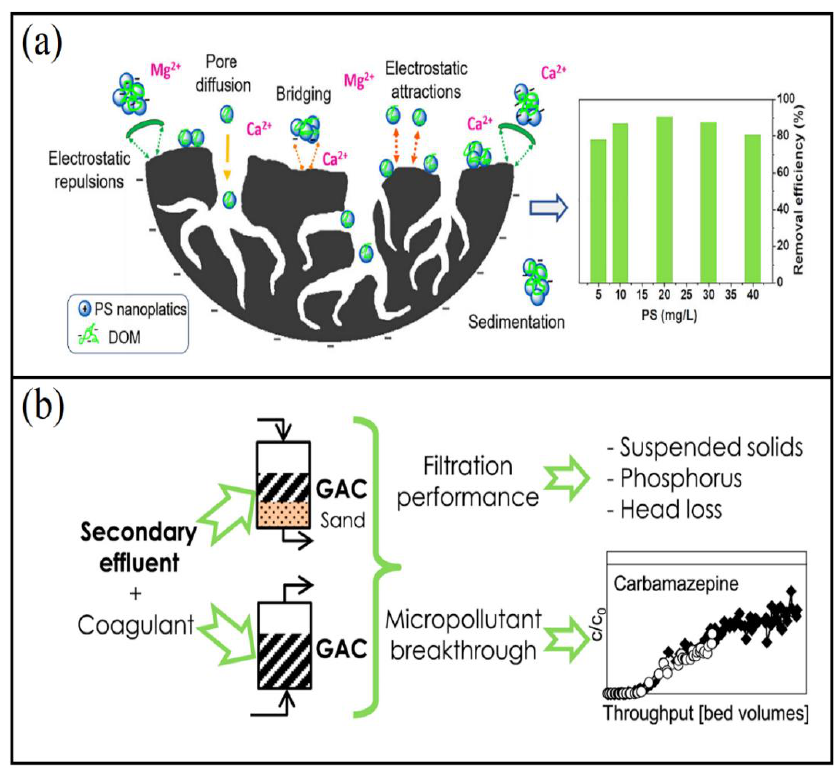
Figure 6. Granular activated carbon-based drinking water filters: ( a ) the adsorption and removal of polystyrene nano plastics, and ( b ) the removal of suspended solids and phosphorus from drinking water. Adapted with permission from ref. [93], 2021, Elsevier ( a ), and [94], 2016, Elsevier ( b ).